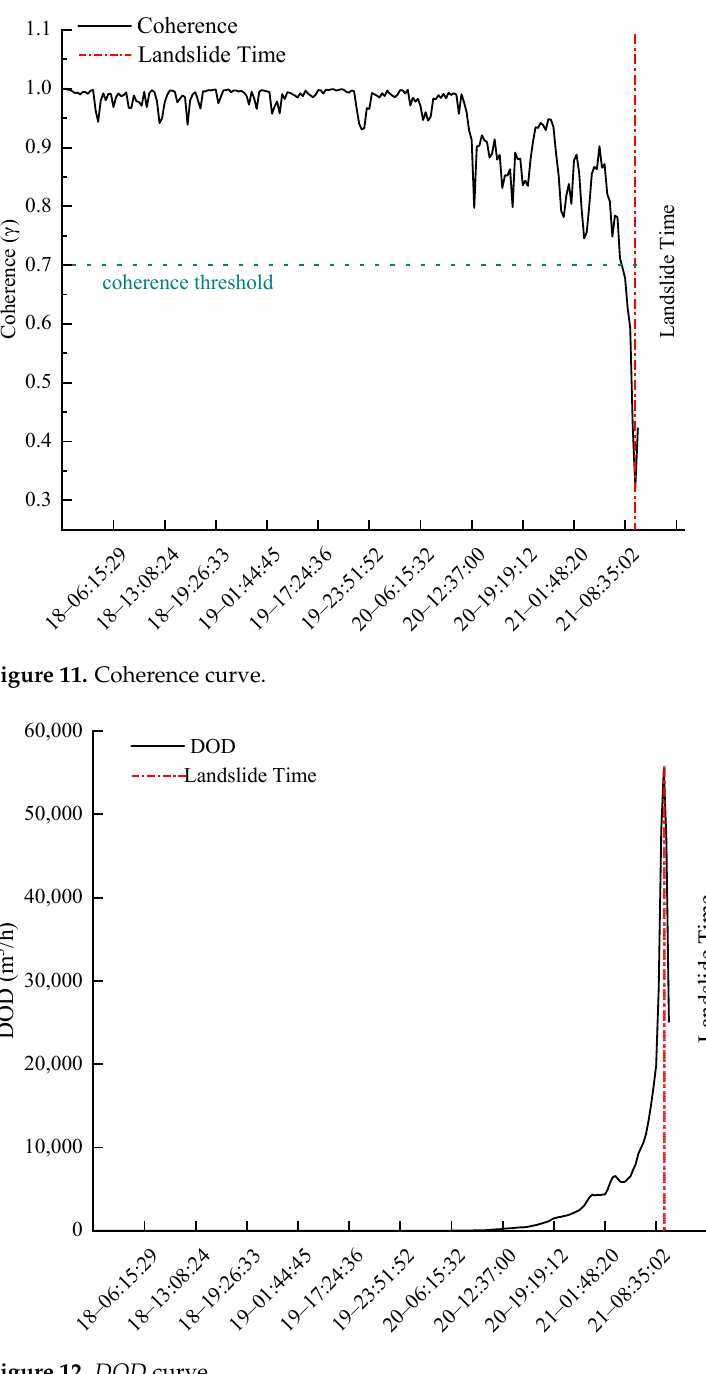
Figure 12. DOD curve. Figure 12. DOD